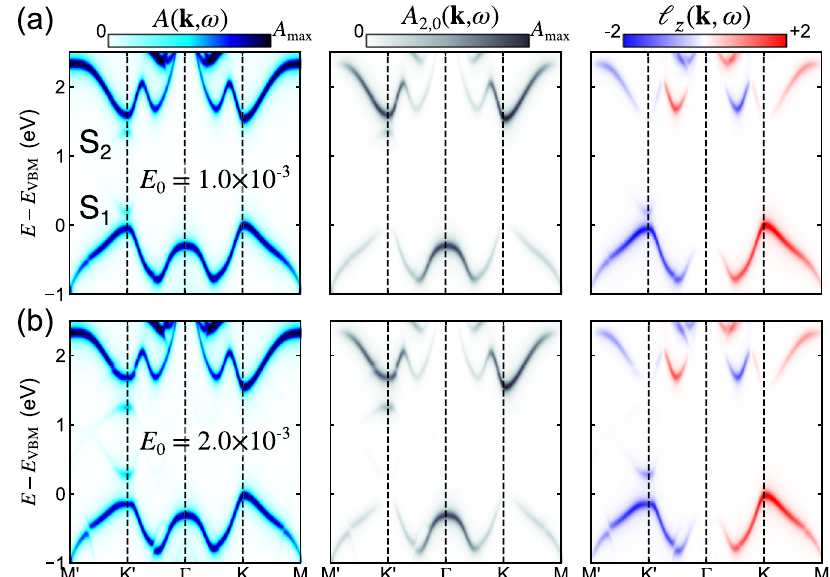
Fig. 3 Floquet spectrum and orbital texture. Spectral function A ( k , ω ) in the presence of a driving laser, associated spectral function A 2,0 ( k , ω ) projected onto ð ‘; m Þ ¼ ð 2 ; 0 Þ (cid:4) d z 2 orbitals, and orbital angular momentum texture ℓ z ( k , ω ) de fi ned by Eq. (7), for ( a ) E 0 = 1.0 × 10 − 3 a.u., and ( b ) E 0 = 2.0 × 10 − 3 a.u. peak pump fi eld strength. The pump photon energy is ℏ ω p = 1.4 eV and the pump fi eld is left-handed circularly